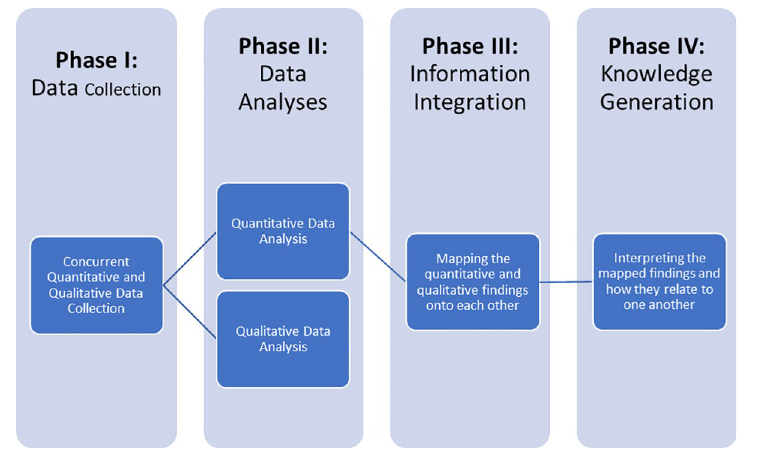
Fig 1. Visual representation of the mixed methods study design adapted for this research